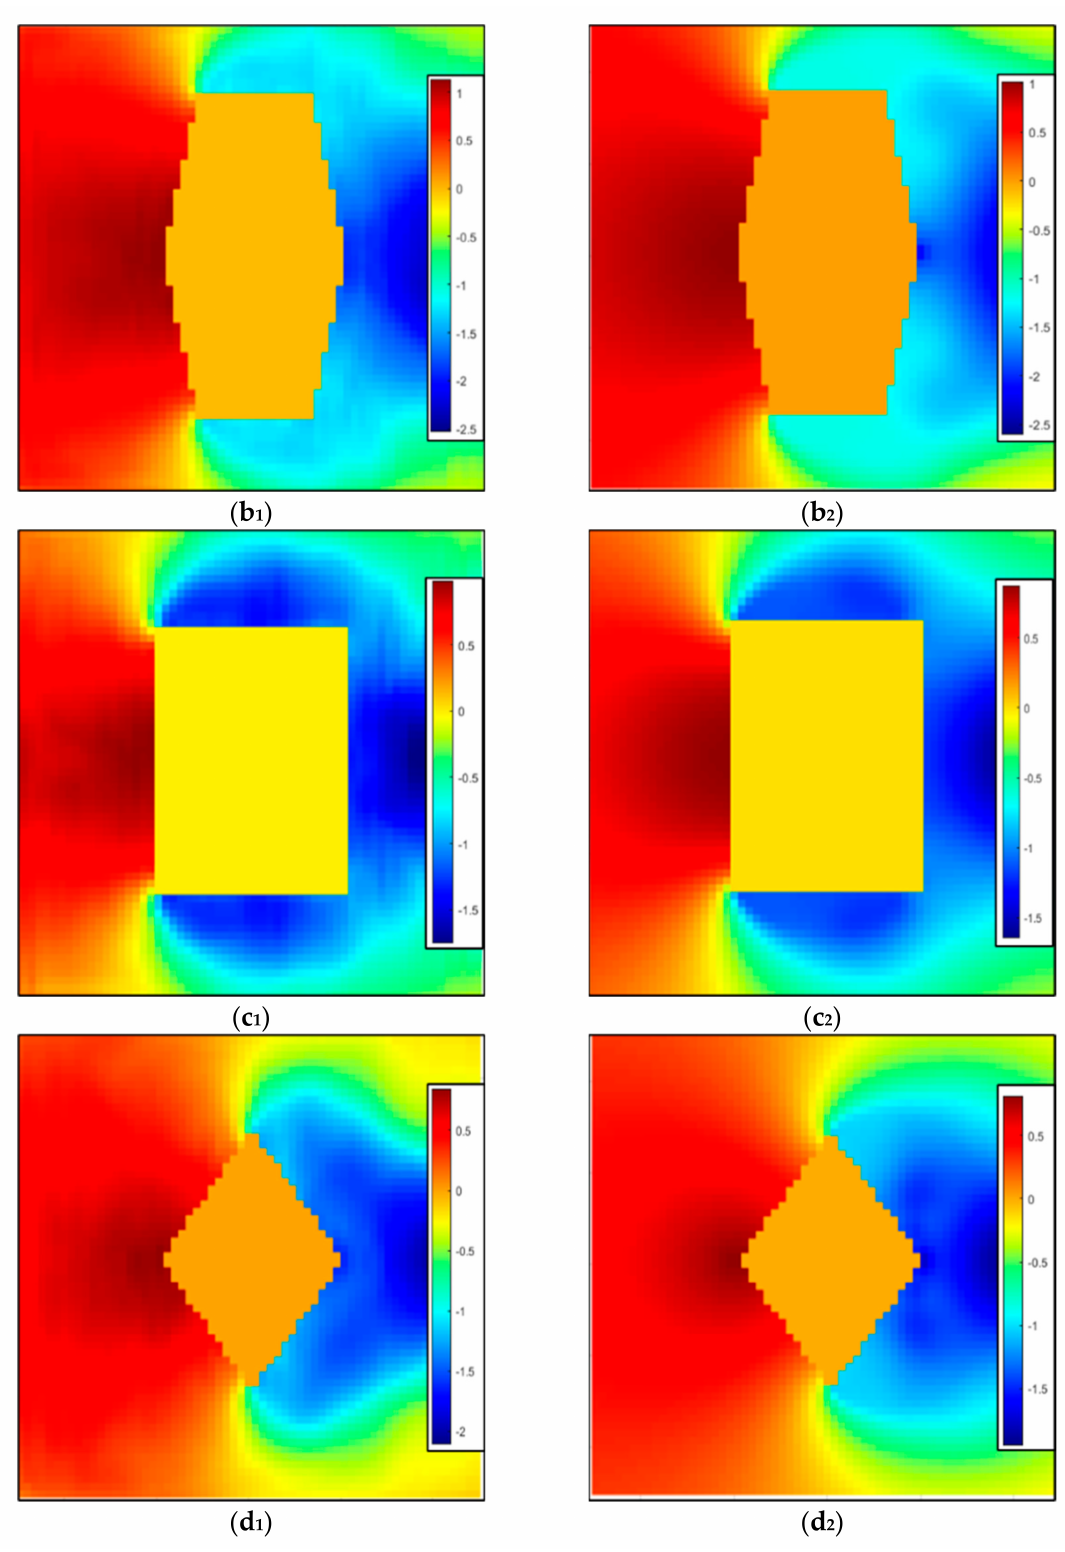
Figure 10. Comparison of pressure field prediction effects of four typical shapes. The first column is the predicted value. ( a 1 ) The ellipse with AR = 0.71. ( b 1 ) The hexagon with AR = 0.56 R = 0.3. ( c 1 ) The rectangle with AR = 0.71. ( d 1 ) The diamond with AR = 0.71. The second column is the true value. ( a 2 ) The ellipse with AR = 0.71. ( b 2 ) The hexagon with AR = 0.56 R = 0.3. ( c 2 ) The rectangle with AR = 0.71. ( d 2 ) The diamond with AR =